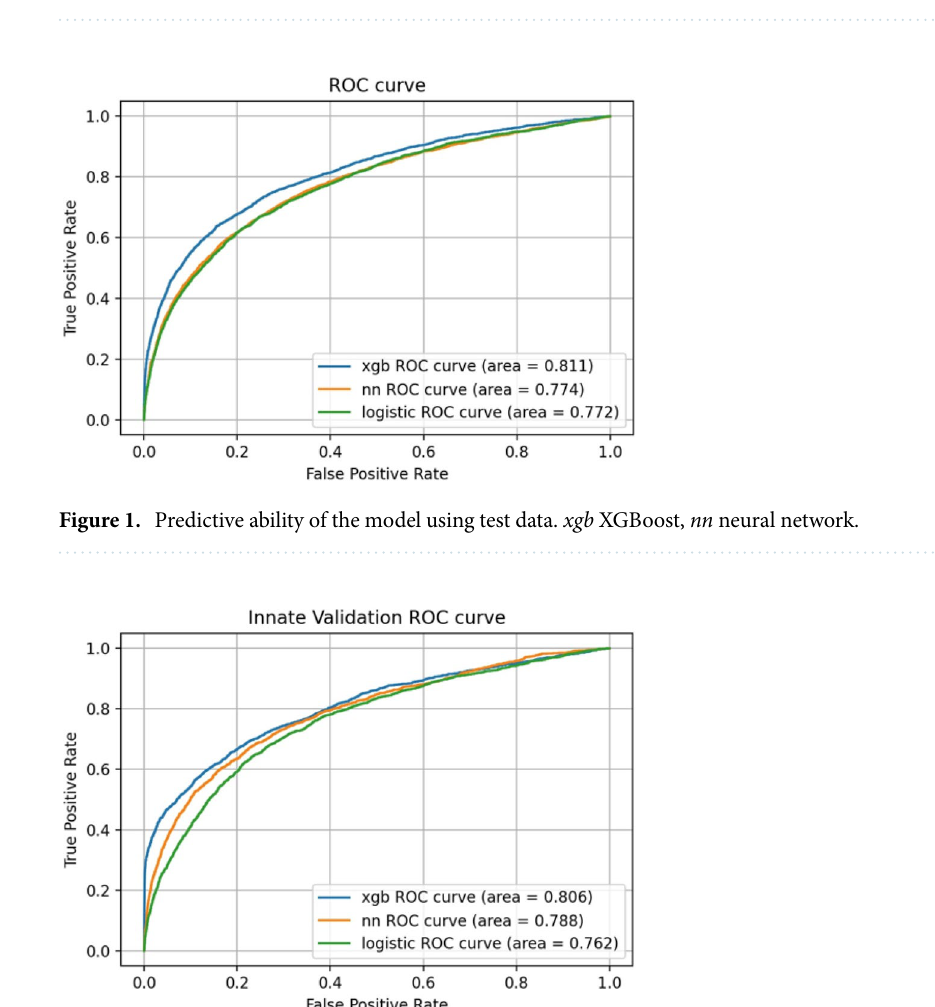
Table 2. Parameters of predictive model.